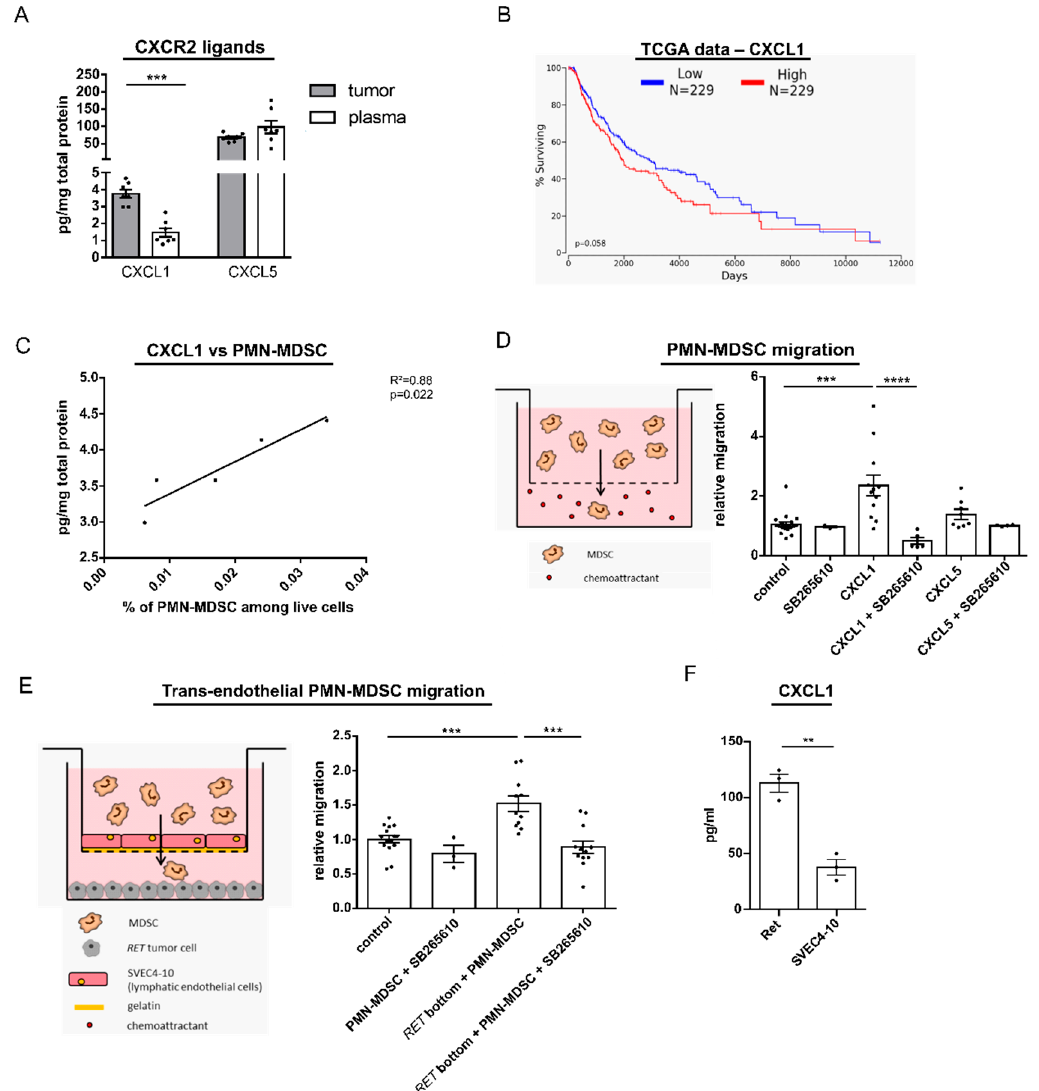
Figure 4. Characterization of CXCR2/CXCL1 and CXCR2/CXCL5 interaction in melanoma. ( A ) Concentrations of CXCL1 and CXCL5 were determined in plasma and lysates of skin tumors of RET transgenic mice by bio-plex analysis and expressed as pg/mg total protein (mean ± SEM; n = 7–8). ( B ) Overall survival analysis of melanoma patients ( n = 458) stratified into those with low and high CXCL1 expression (lower and upper percentile 50). ( C ) The intratumoral levels of CXCL1 expressed as pg/mg protein were plotted against the percentage of tumor infiltrating PMN-MDSC among total live cells from respective mice ( n = 5). The correlation was evaluated by a linear regression analysis. ( D ) Spontaneous migration (control) and migration towards CXCL1 (100 ng/mL) or CXCL5 (100 ng/mL) of PMN-MDSC from the BM of tumor bearing RET transgenic mice was determined in the presence and absence of the CXCR2 inhibitor SB265610 (100 nM) after the incubation for 24 h in a transwell assay. Data are normalized to the spontaneous migration of PMN-MDSC (control) (mean ± SEM; n = 3–19). ( E ) Spontaneous migration of PMN-MDSC from the BM of tumor bearing transgenic mice and their migration towards Ret tumor cells through SVEC4-10 lymphatic endothelial cells were determined in the presence and absence of the CXCR2 inhibitor SB265610 (100 nM) in a transwell assay after 24 h. Data are normalized to the spontaneous migration of PMN-MDSC (control) (mean ± SEM; n = 3–15). ( F ) Production of CXCL1 by Ret tumor cells and SVEC4-10 endothelial cells determined by Enzyme-Linked Immunosorbent Assay (ELISA) in cell culture supernatant (mean ± SEM; n = 3). ** p < 0.01, *** p < 0.001, **** p <